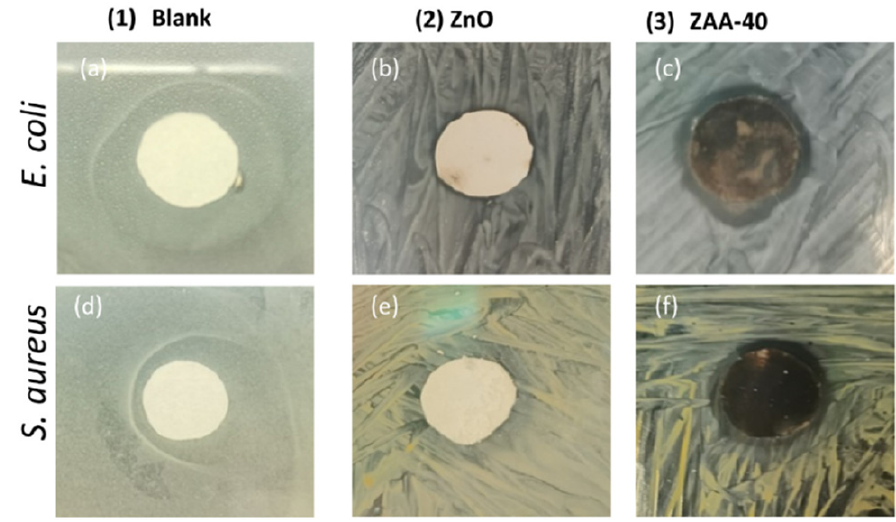
Figure 19. Photographs of antibacterial test results of ZnO, Ag2MoO4/Ag, and ZAA samples against Escherichia coli ( a – c ) and Staphylococcus aureus ( d – f ). Reprinted/adapted with permission from Ref. [184]. Copyright© 2022, Elsevier B.V.